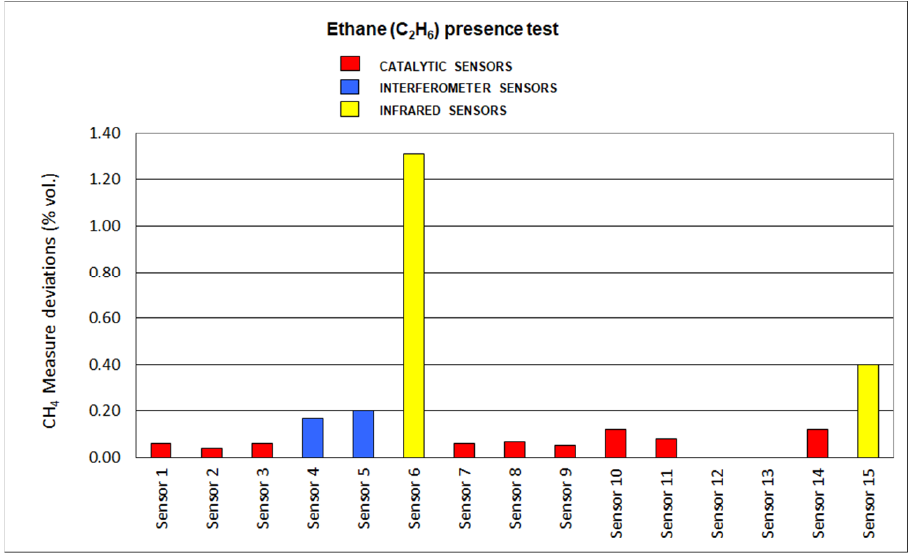
Figure 14. Ethane dioxide presence results.